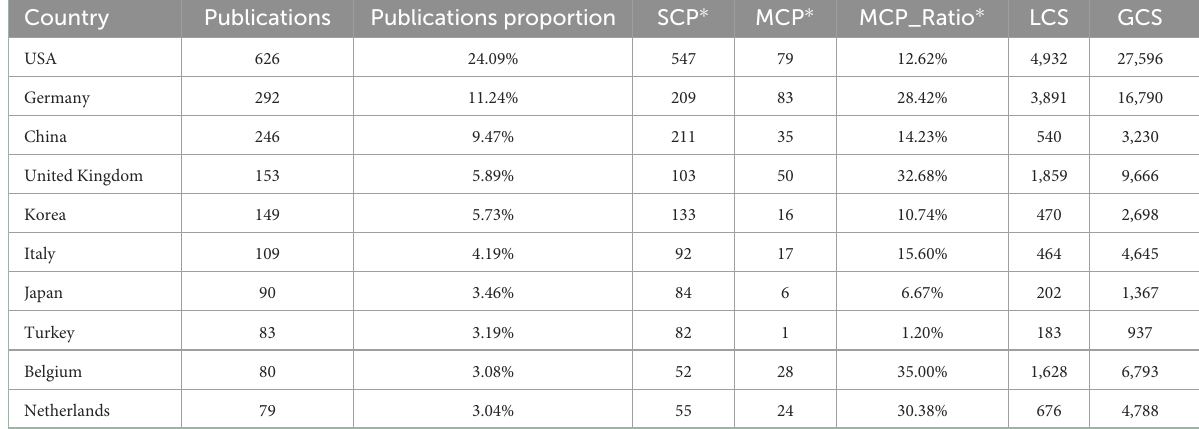
TABLE 3 Top ten countries in the tinnitus treatment field.